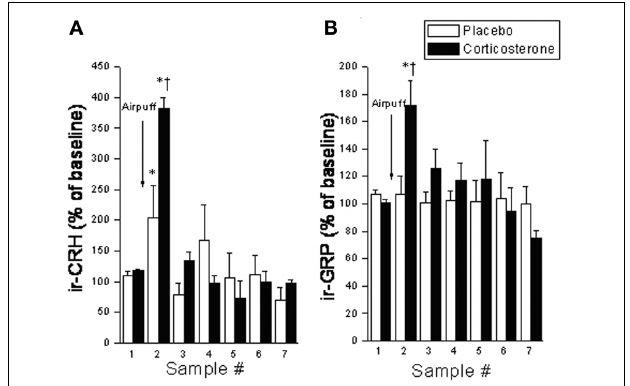
FIGURE 3 | Interstitial levels of (A) immunoreactive (ir) -CRF or (B) ir-GRP (expressed as a percentage of baseline values) at the CeA under basal conditions and following exposure to an airpuff stressor (5 airpuffs; 5s puff/min) in placebo or corticosterone pellet (100mg, 21 day slow release) implanted rats. Chronic corticosterone exposure potentiated the stressor-elicited release of CRF and GRP. ∗ Significantly different from respective baseline sample at p < 0 . 05. † Significantly different from (sample-matched) placebo control condition at p < 0 .